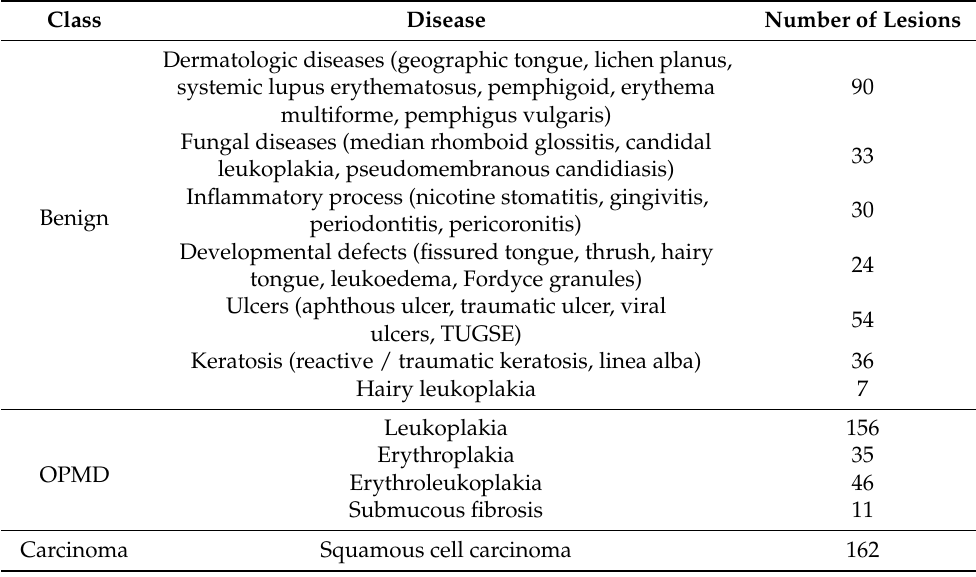
Table 1. Lesion classes and corresponding oral diseases included within each class.